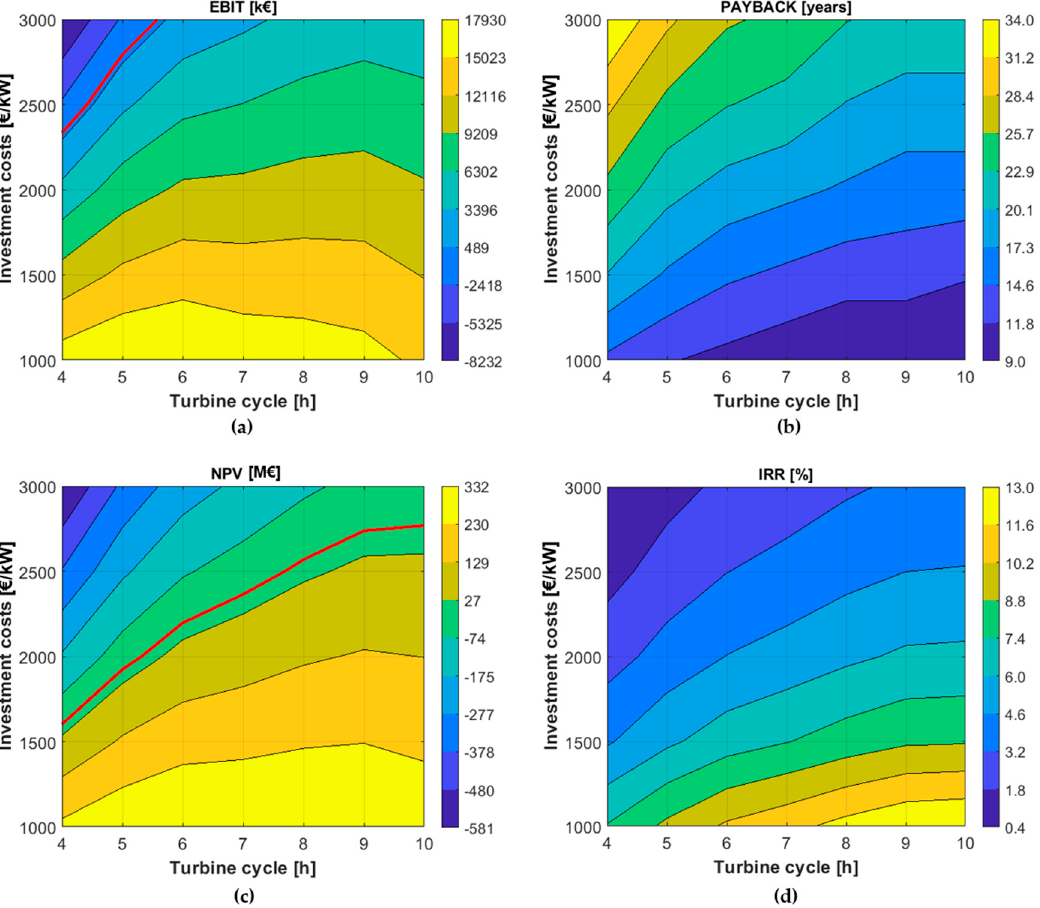
Figure 6. Feasibility analysis of HPS 3 with surface upper reservoir, considering DTCs between 4 and 10 h and investment costs between 1000 and 3000 € kW − 1 . ( a ) Earnings before interest and taxes (EBIT), where the red line represents zero EBIT; ( b ) payback period; ( c ) net present value (NPV), where the red line represents zero NPV; ( d ) internal rate of return.